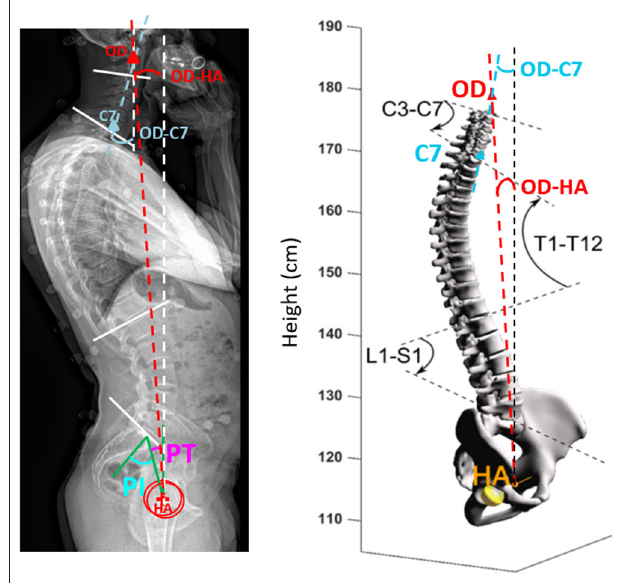
FIGURE 1 | Analysis of postural alignment using 3D biplanar imaging. PT pelvic tilt, PI pelvic incidence, OD superior tip of the odontoid process of C2, OD-HA the angle between the vertical plane and the line through OD and the midpoint of the line connecting the center of the two femoral heads, OD-C7 the angle between the vertical plane and the line through OD and C7. C3–C7, 3D cervical curvature; T1–T12, 3D thoracic curvature; L1–S1, 3D sacral